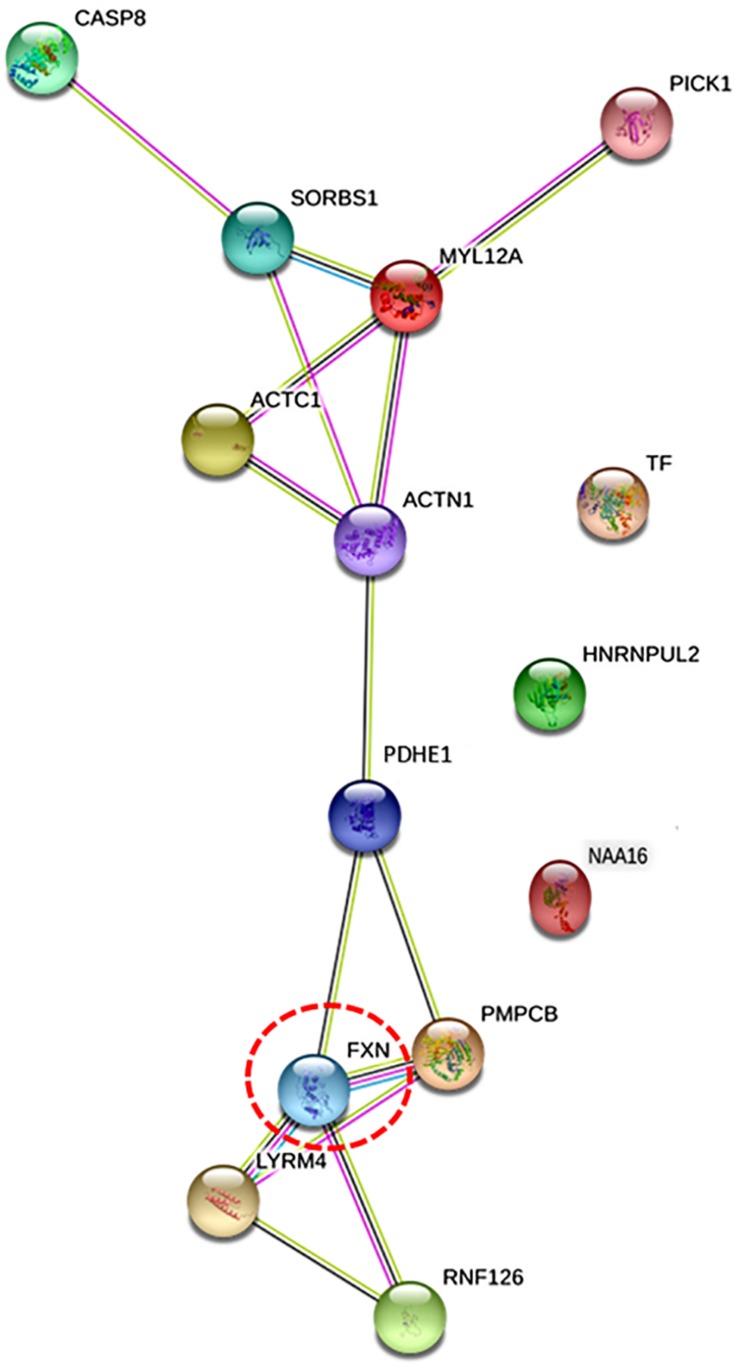
The figure illustrates protein network interaction of eight differentially expressed proteins identified with protein of interest, frataxin (Fxn) using STRING software. Proteins that were found to have direct interactions with frataxin are also included (LYRM4, PMPCB, RNF126, and ACTN1). Nodes denote genes/proteins. Frataxin is highlighted in red circle [protein interacting with C kinase (PICK1) was included in the network by software as a MYL12A interacting protein].